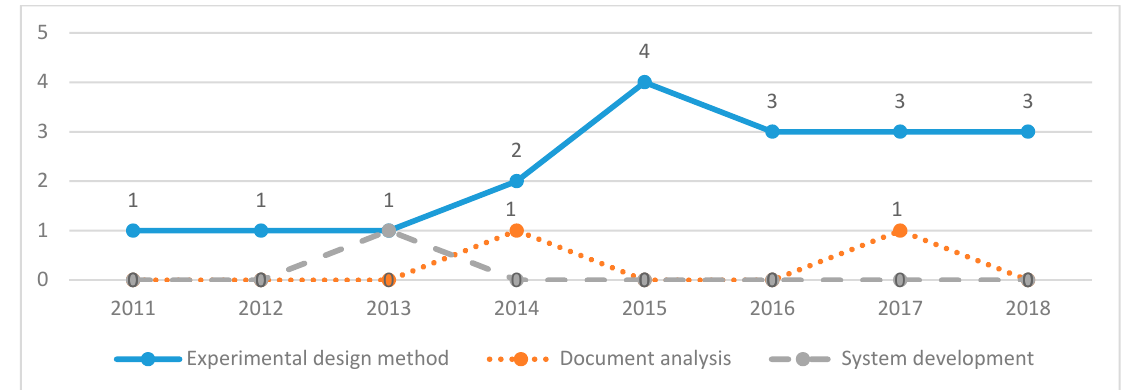
Figure 13. The number of papers published in research methods by year.